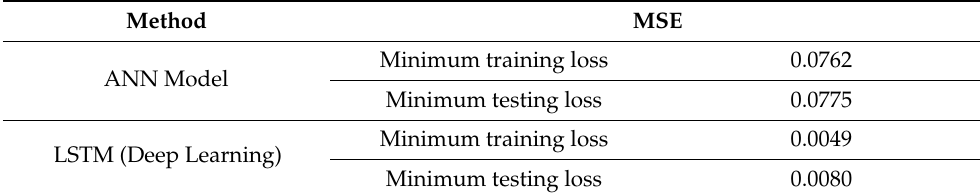
Table 6. Error comparison of models after 500 epochs.